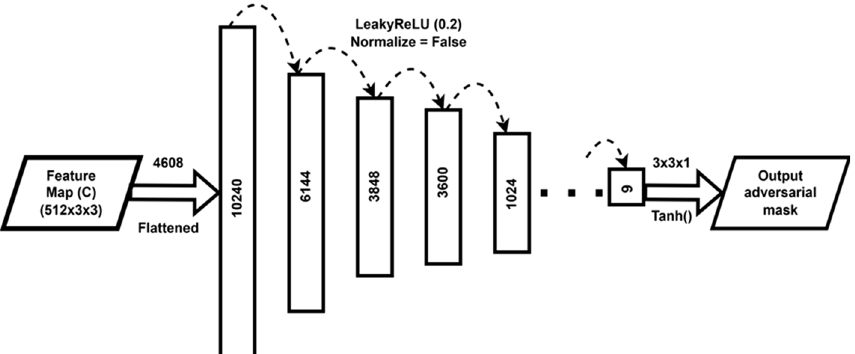
Fig. 4 The architecture of the FC‑22 (RTDG) generator